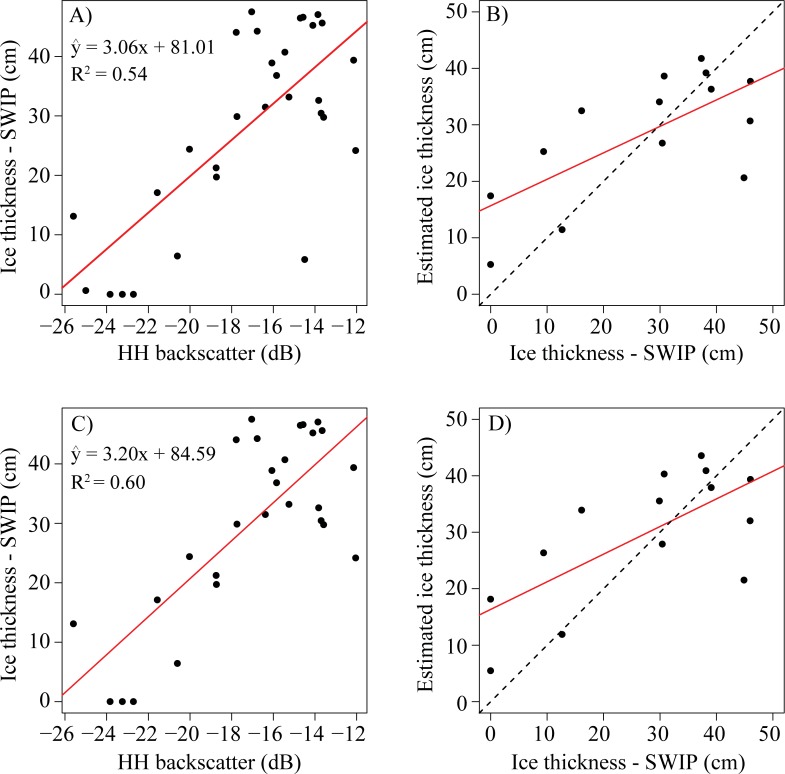
Results of developing a linear model for estimating ice thickness using HH backscatter.A) and B) (training and validation) show the result of using all data available, while C) and D) (training and validation) show the model result with the two identified outliers (December 10th and 13th, 2016) removed. The dotted line represents a 1:1 relationship between estimated ice thickness and ice thickness measured from the SWIP. The red line in all plots displays the line of best fit.